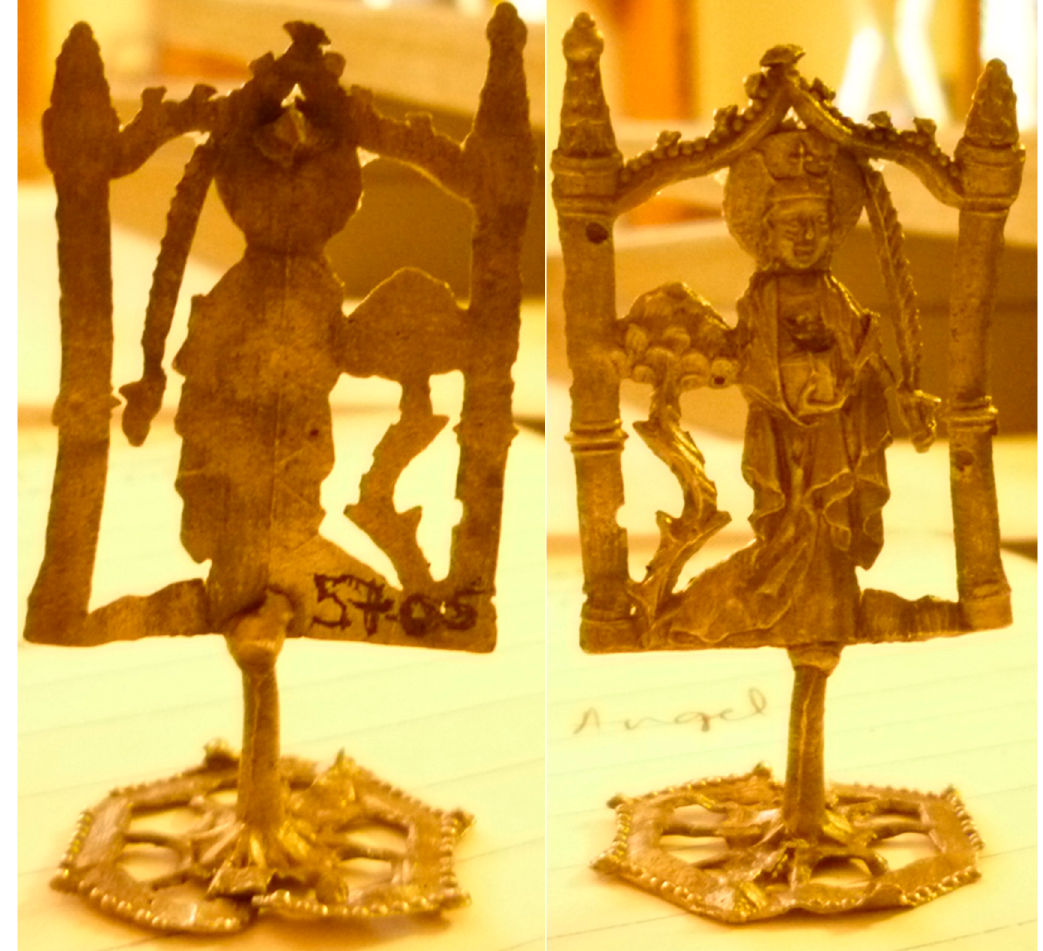
Figure 7. St. Barbara flat figure on framed stand, 15th century. Praha, Museum of Decorative Arts, Prague, Czech Republic. Photo: author.